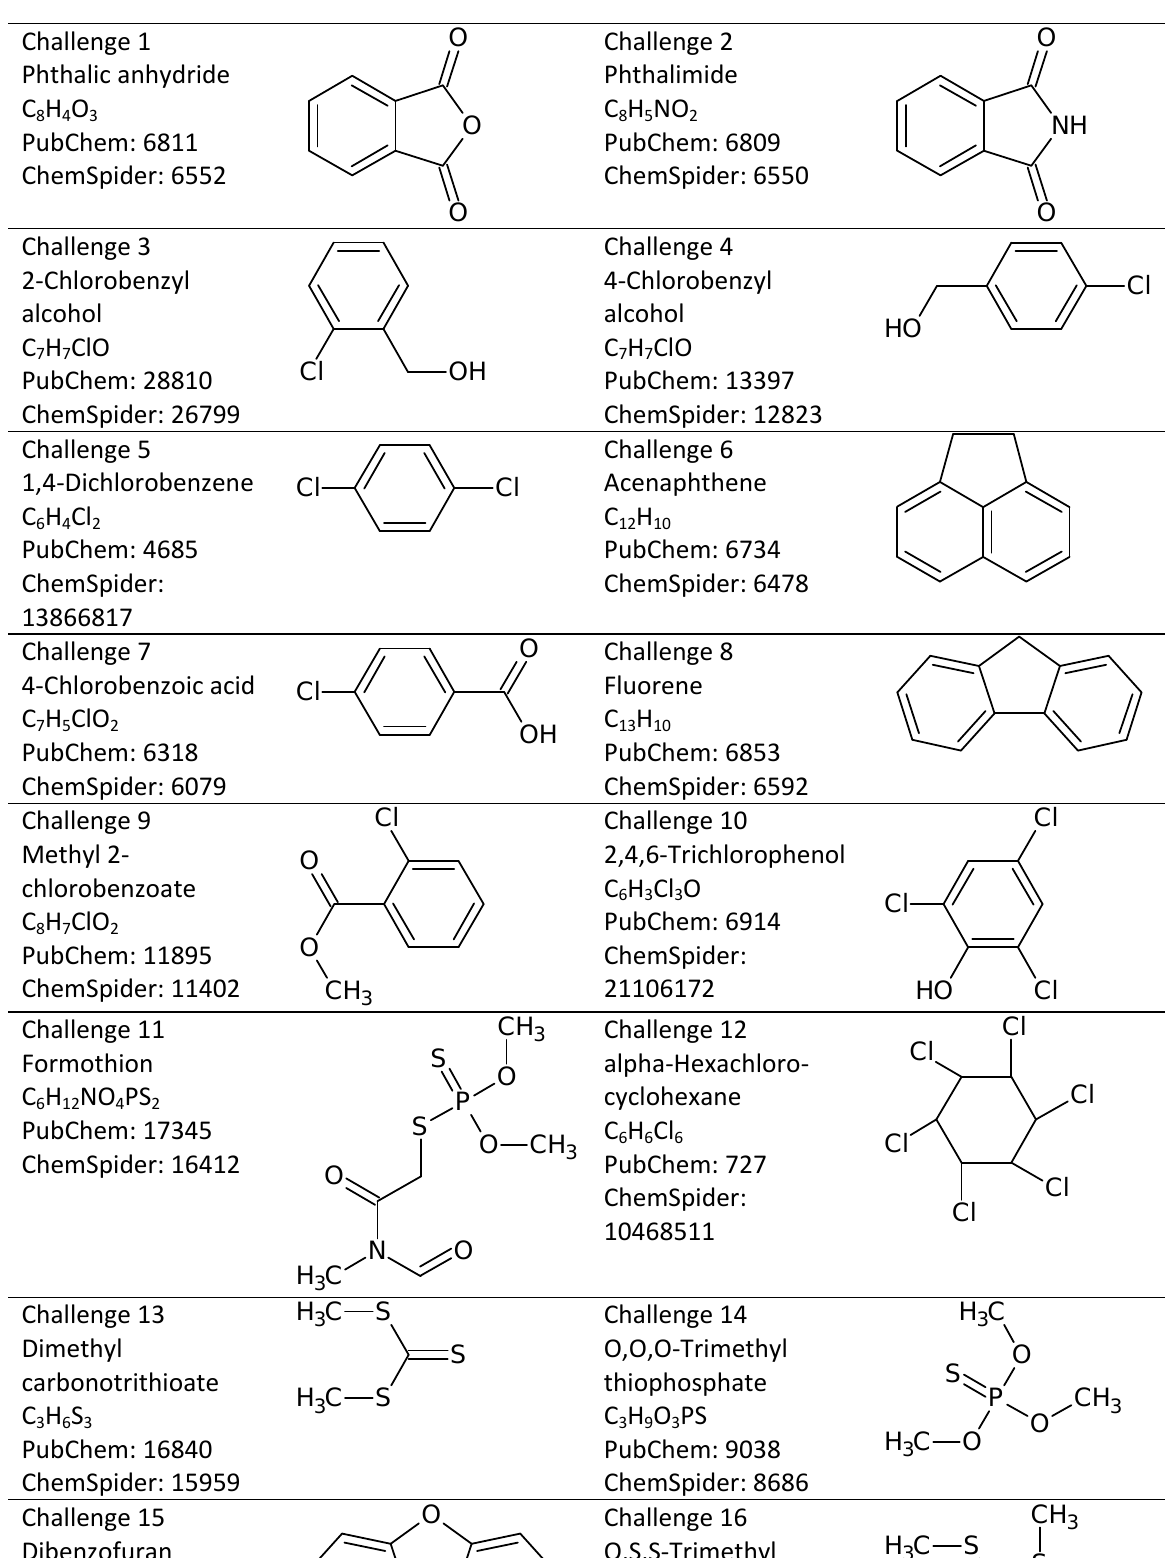
Figure C18. Structures and identifiers for GC-MS Challenges